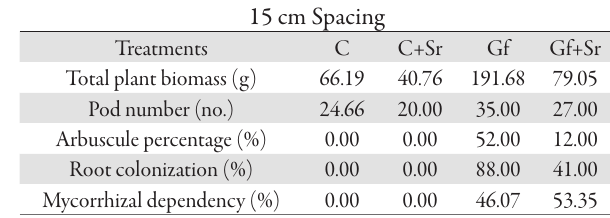
Tab. 5. Total biomass, pod number, arbuscule percentage, root colonization and mycorrhizal dependency in A. hypogaea L. after 90 days of AM inoculation and 75 days of S. rolfsii treatment in